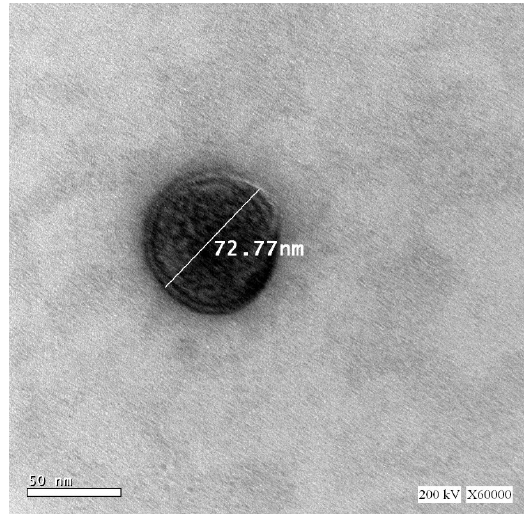
Figure 4. TEM image of PIC-E (X 60,000).